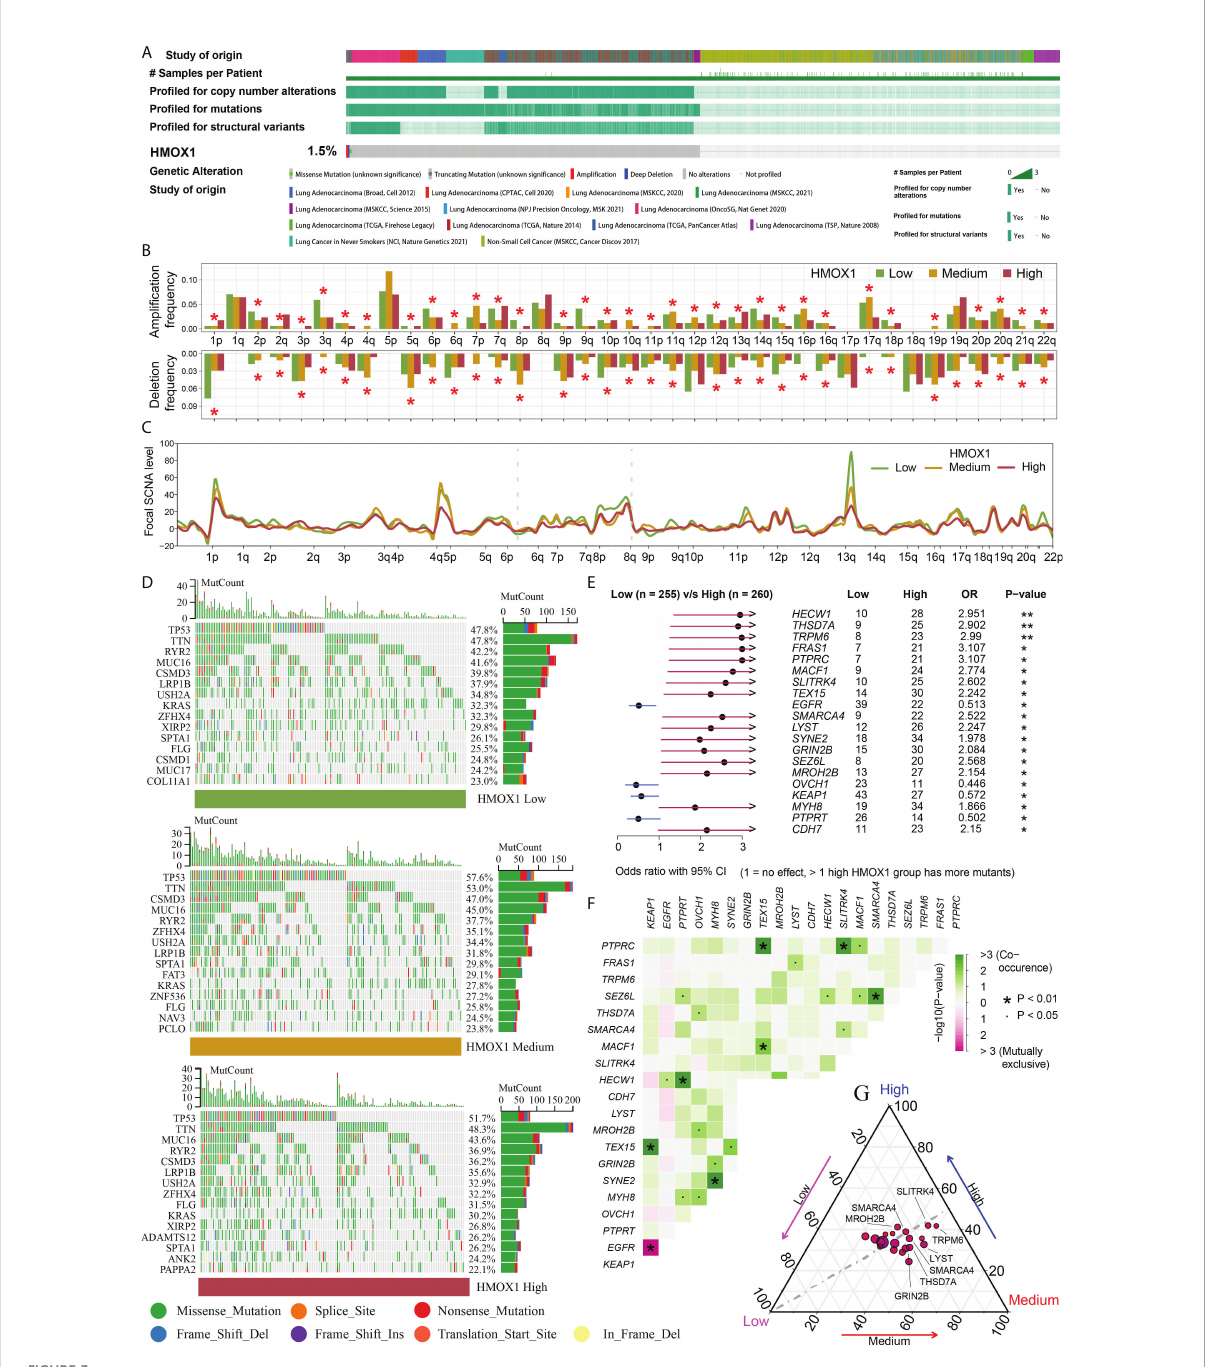
FIGURE 3 Genomic features of different HMOX1 groups. (A) The frequency of HMOX1 copy number alterations (CNAs) and mutations in the cBioPortal database. (B) Comparison of arm-level ampli fi cation and deletion frequencies among the high, medium, and low HMOX1 groups. (C) Comparison of focal-level ampli fi cation and deletion frequencies among the high, medium, and low HMOX1 groups. (D) The waterfall plots showing the mutation landscapes in the high, medium, and low HMOX1 groups. (E) The forest plot listing the top 20 most differentially mutated genes between the high and low HMOX1 groups. (F) The heatmap showing the concurrence or mutual exclusivity of these 20 mutated genes between the high and low HMOX1 groups. (G) The ternary plot showing the mutation frequency distribution of these 20 genes among the high, medium, and low HMOX1 groups. *P < 0.05; **P <